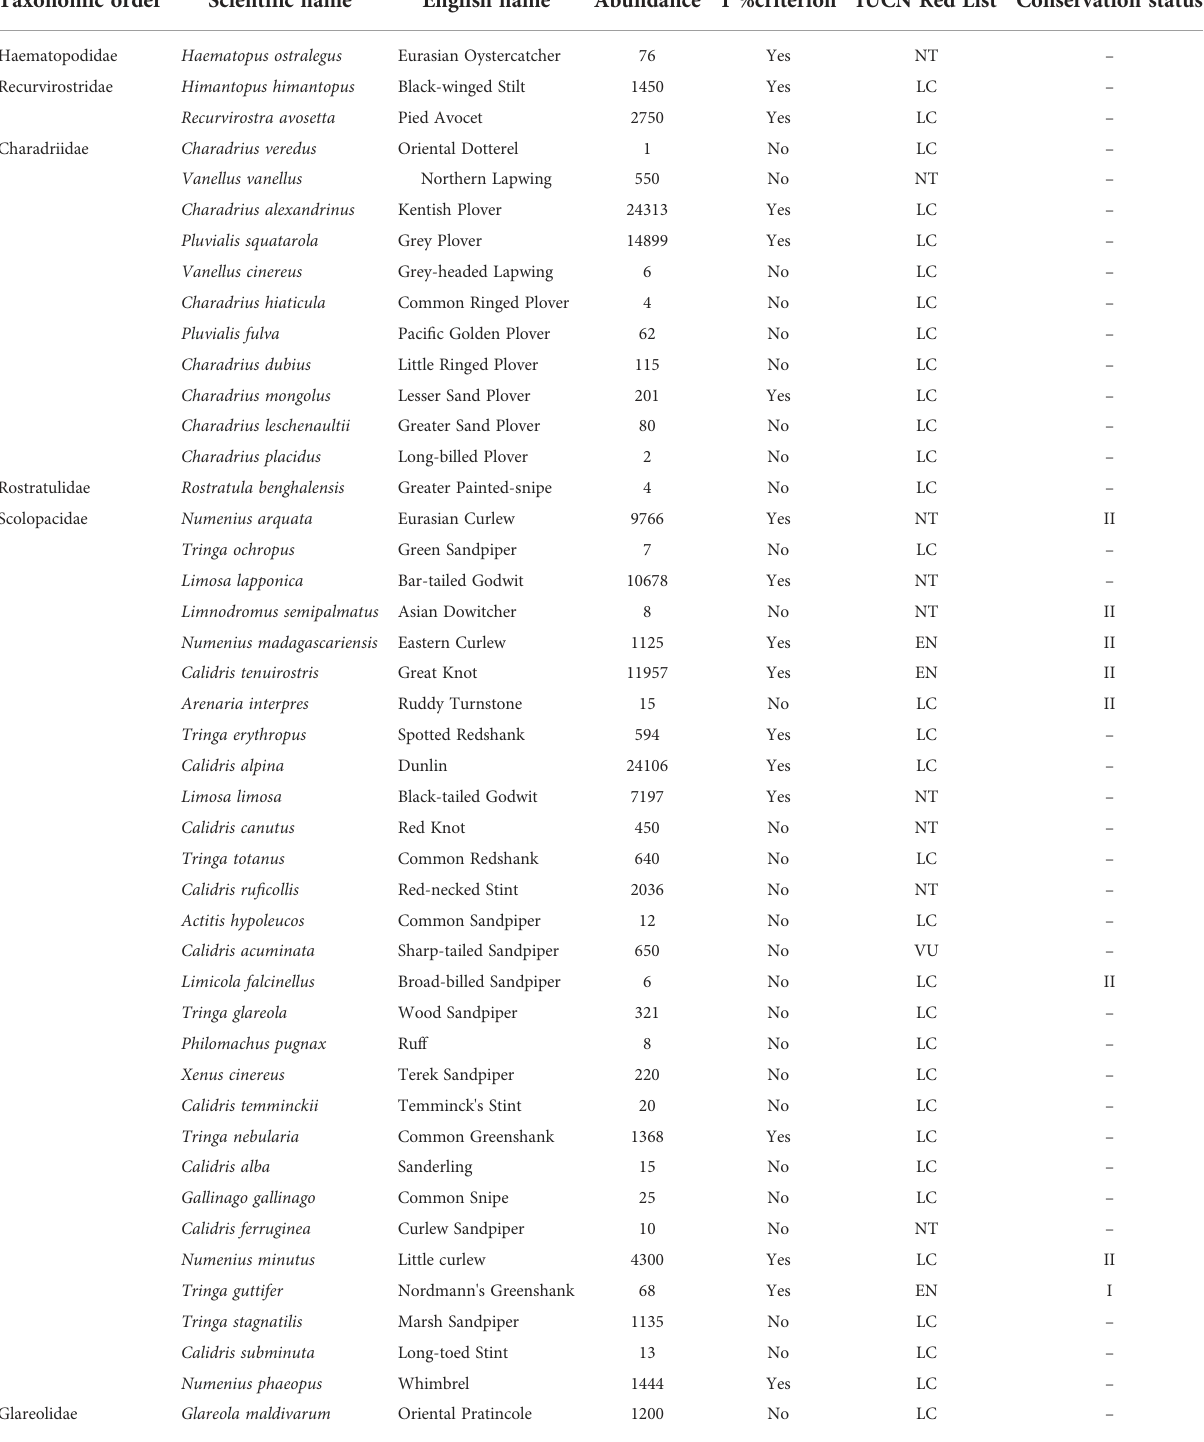
TABLE 2 Maximum abundance of shorebirds and their IUCN Red List and conservation status throughout the 25-year survey period. Taxonomic